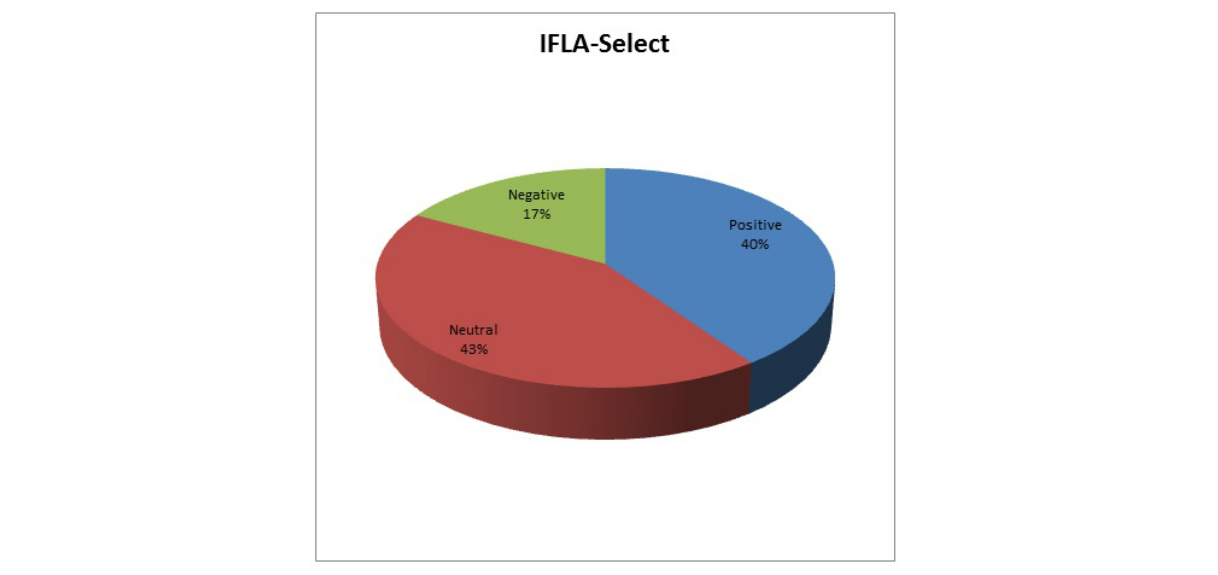
Figure 7. Users' responses mapped to the IFLA-Select requirement.